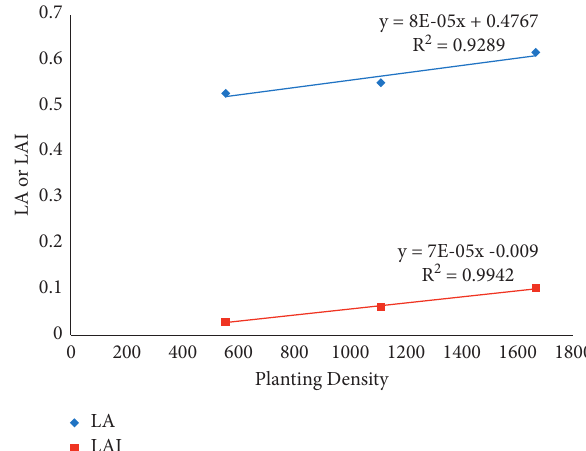
Figure 7: Correlation of plantain population density and leaf area (LA) (m 2 ), and leaf area index (LAI) at Ellembelle.